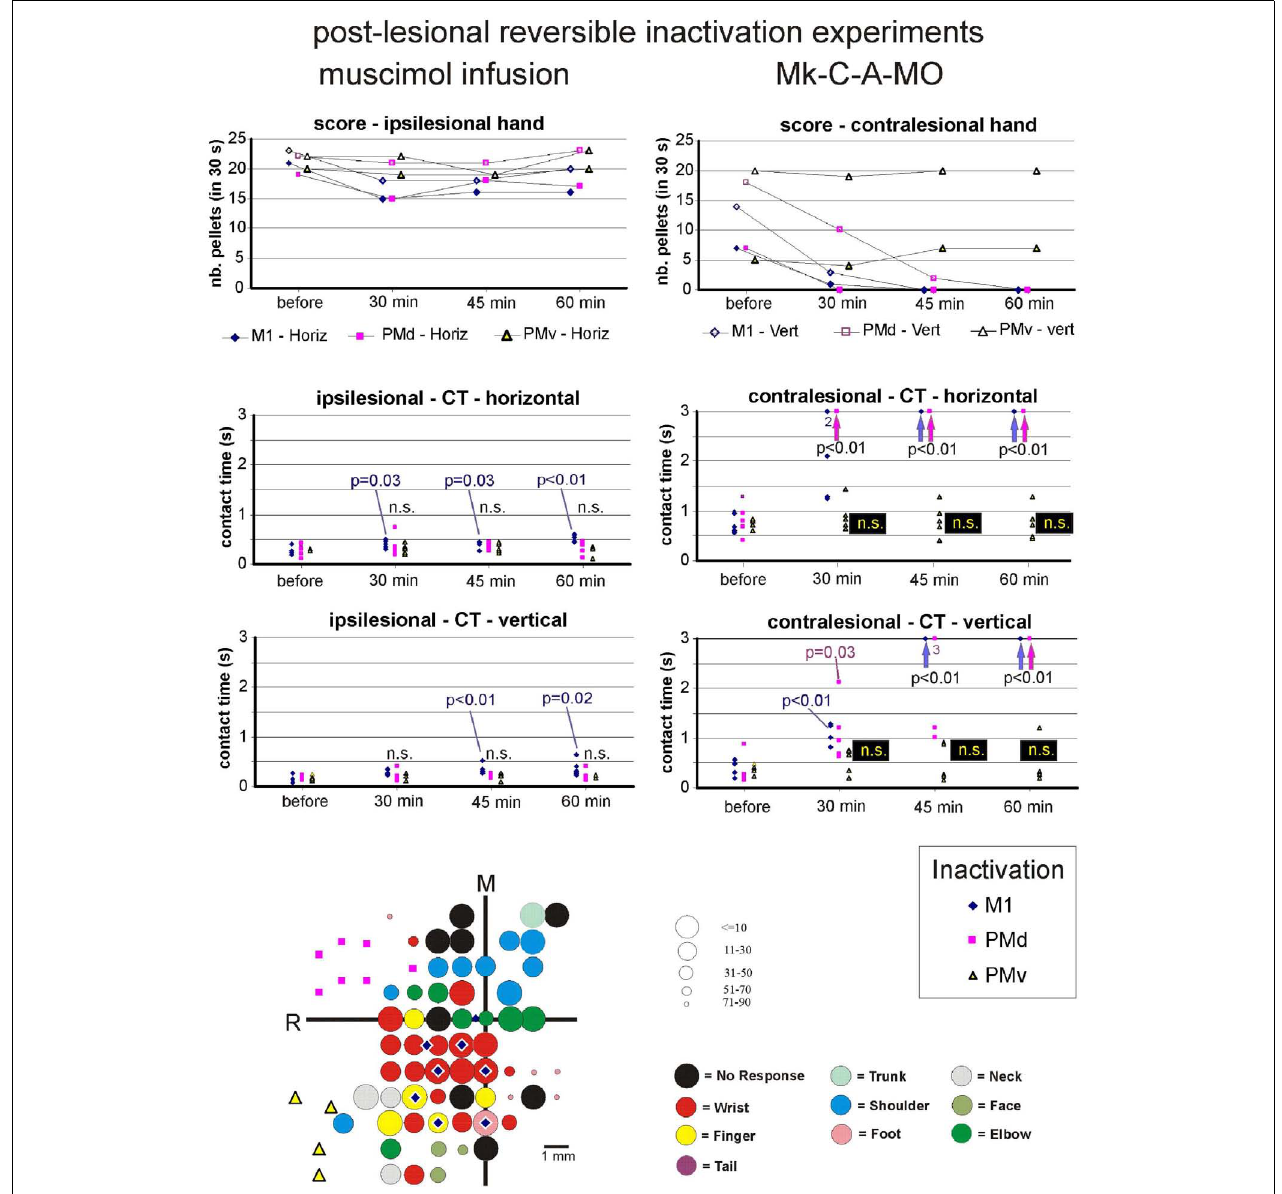
FIGURE 9 | Inactivation data and post-lesion ICMS data for Mk-C-A-MO (same conventions as in Figure 8)